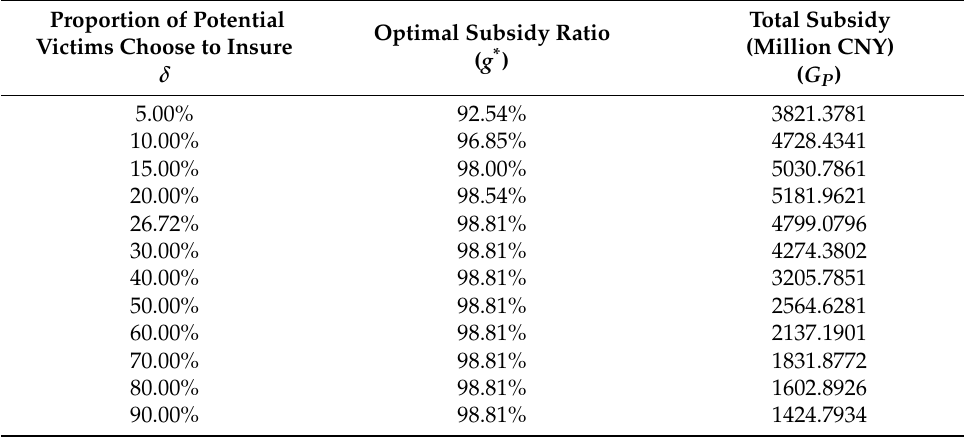
Table 4. Results of the optimal subsidy for storm surge risk index